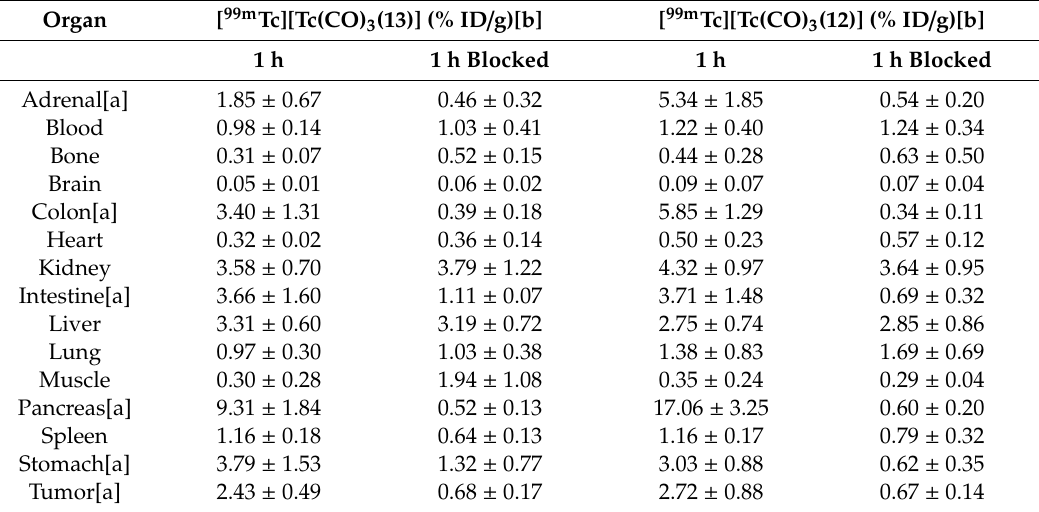
Table 3. Biodistribution data of radiolabeled peptide conjugates in nude mice bearing PC-3 xenografts.